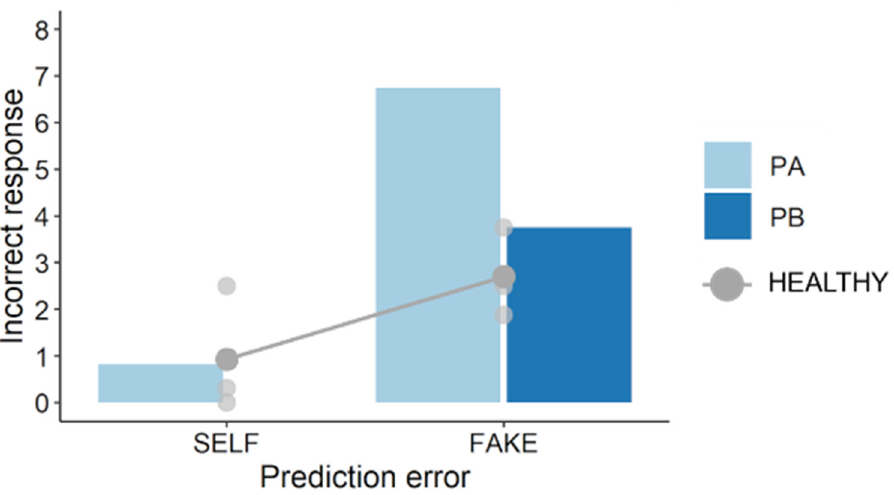
Figure 4. Incorrect responses in self-other judgments. In the FAKE condition, the incorrect response score in PA (6.75) was higher than that in PB (3.75) or healthy participants (3.75; 2.50; 1.88). PB (and one healthy participant) made no incorrect responses in the SELF condition. Grey line shows the mean score in healthy participants.